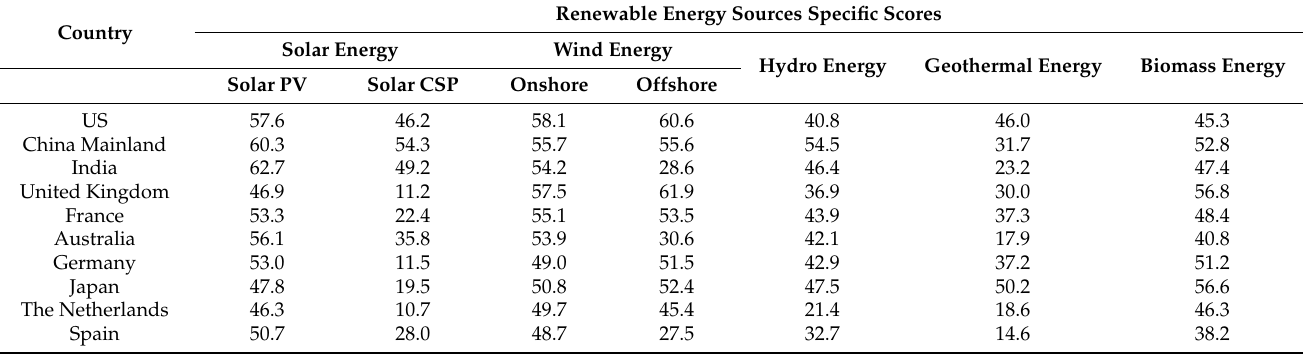
Table 3. Renewable energy sources specific RECAI